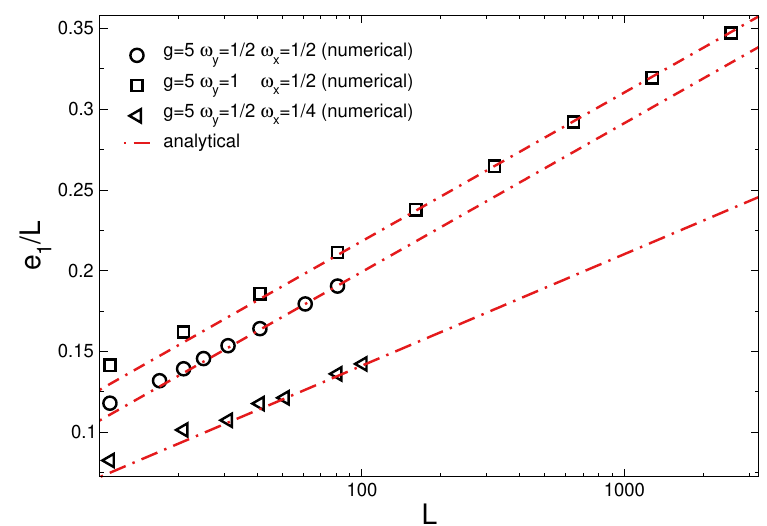
Figure 5: Largest eigenvalue e of the correlation matrix (cid:67) restricted to A . We plot 1 / L versus L . Note the logarithmic scale on the x -axis. Symbols are exact numer- e 1 ical data. The dashed-dotted lines are analytic predictions. Note that for ω boundary between the two subsystems has a corner (see Fig. 1